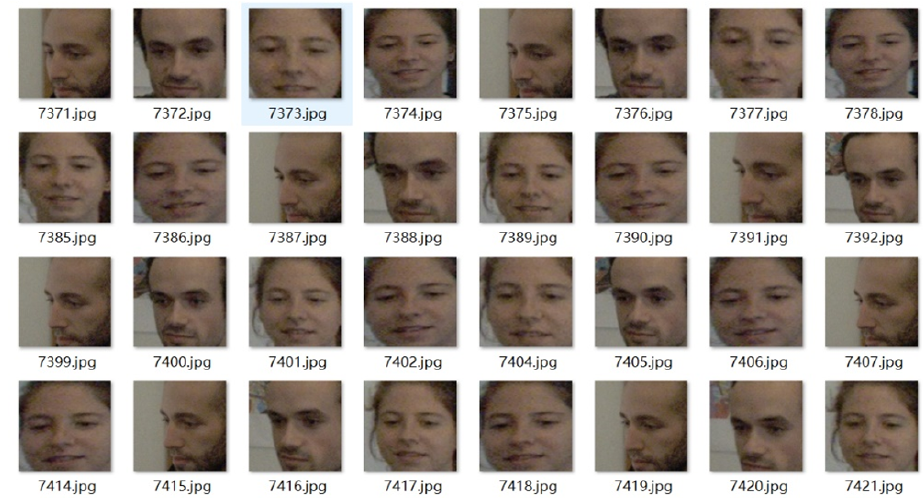
Figure 7. Processed images in Gaze360.